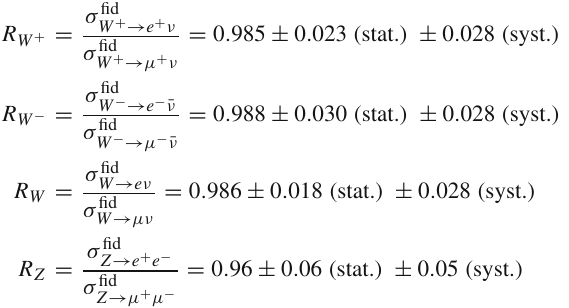
− σ fid σ fid W + W − σ fid + σ fid W + W −